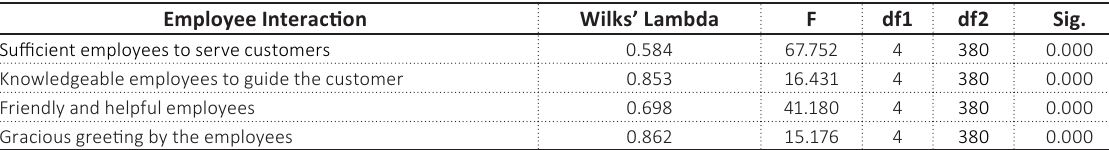
Table 6. Discriminant validity for employee